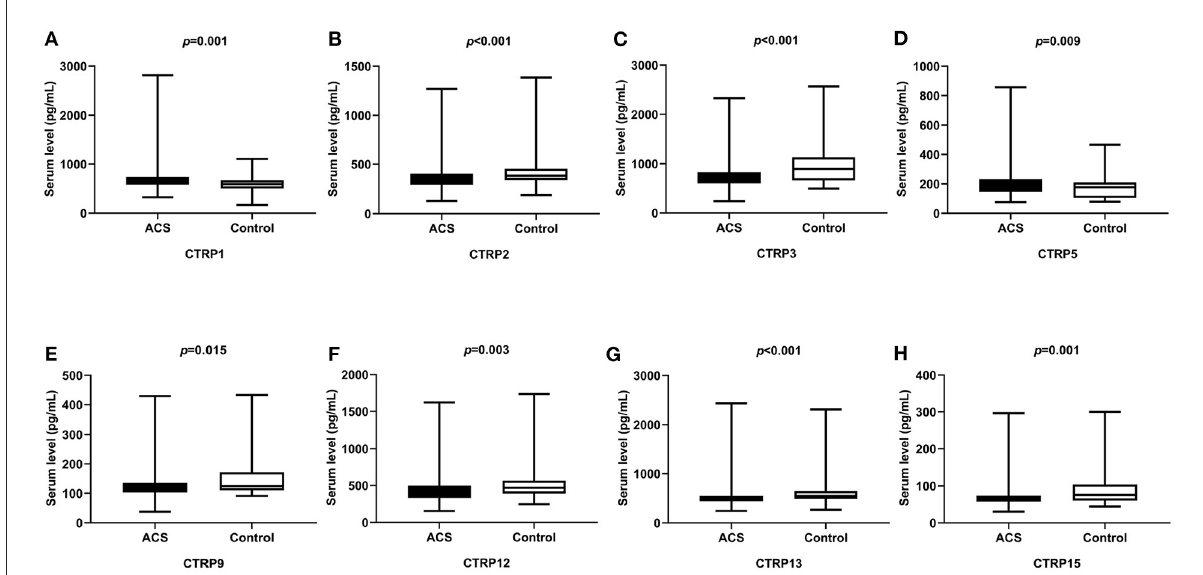
FIGURE1 Comparison of serum CTRP family levels between ACS and control groups. (A) CTRP1, (B) CTRP2, (C) CTRP3, (D) CTRP5, (E) CTRP9, (F) CTRP12, (G) CTRP13, and (H) CTRP15.